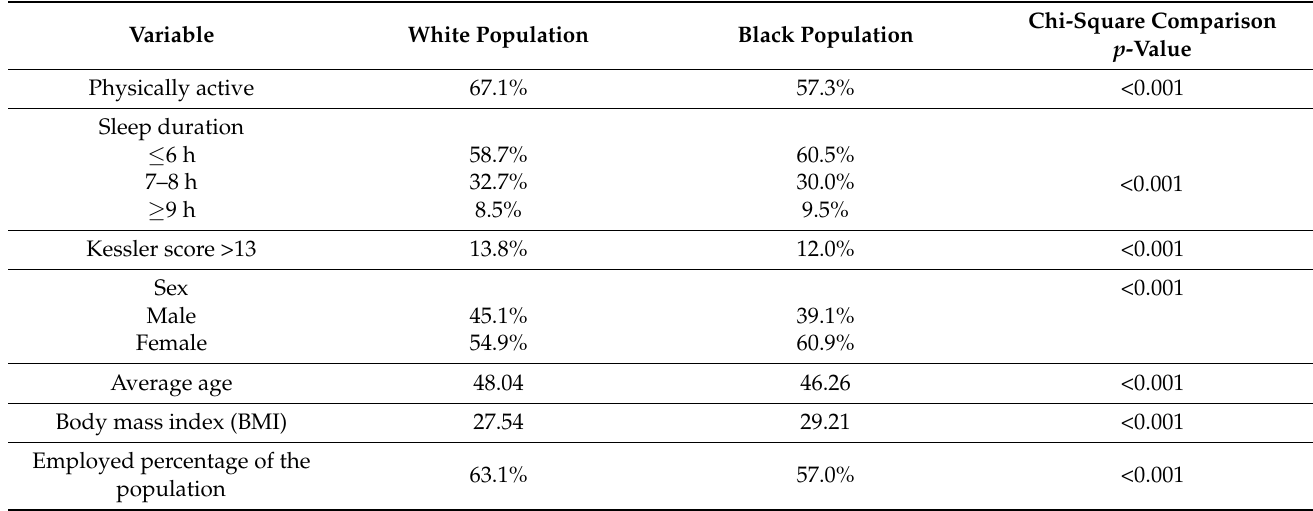
Table 1. Group comparison of key variables between Blacks and Whites ( n =